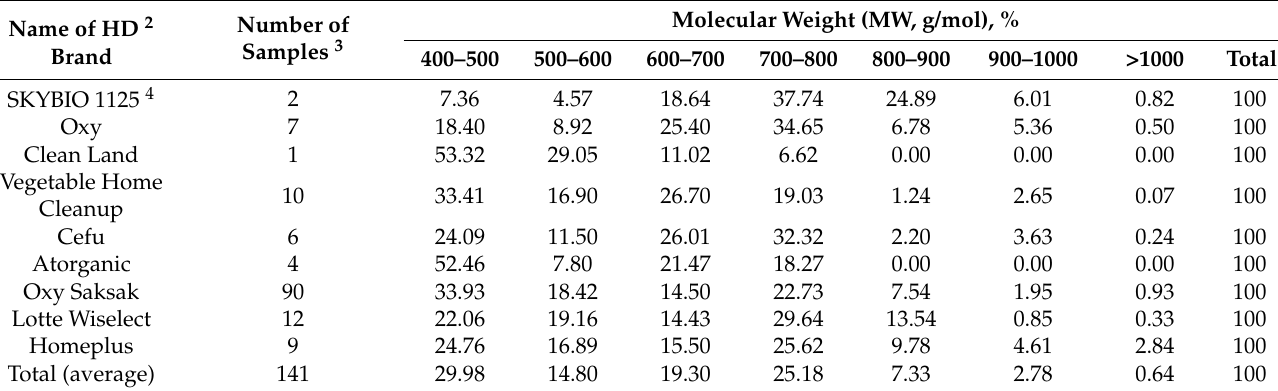
Table 2. Distribution of molecular weight in PHMG 1 .